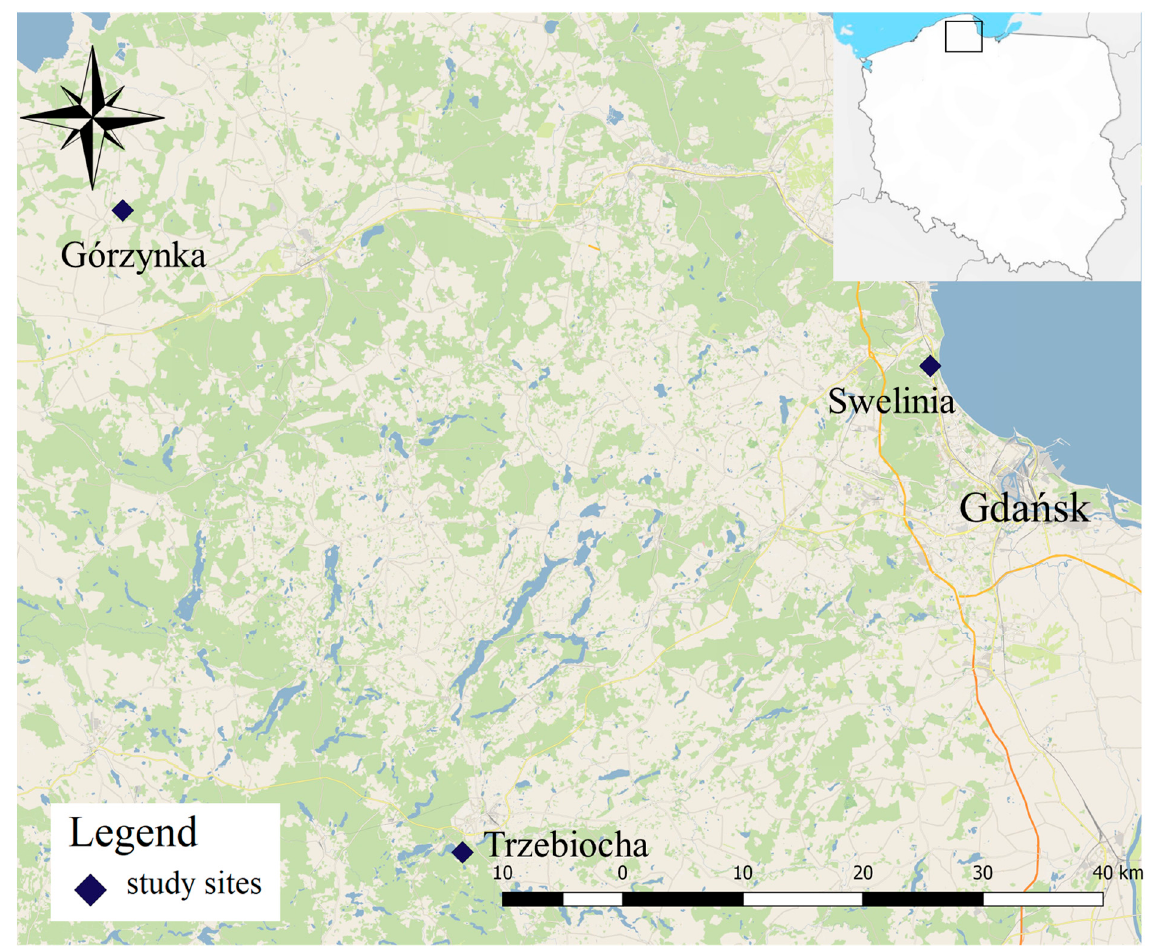
Figure 1. Locations of the study sites at three small streams modified by Eurasian beavers (source of background map: Open Street Map). Table 1. Research effort and timing for the three sites. D—dam; L—log;